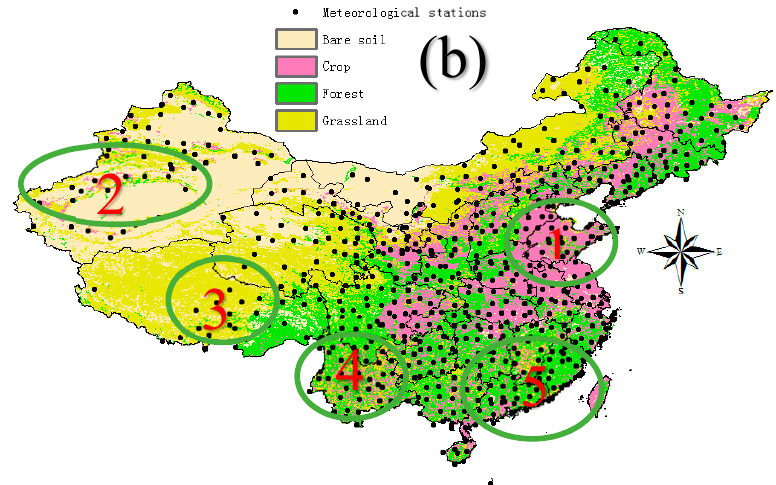
Figure 6. ( a ) The spatial distributions of scaling exponents for the daily SSDA time series over China; ( b ) The spatial distributions of land use category for the daily SSDA time series over China.